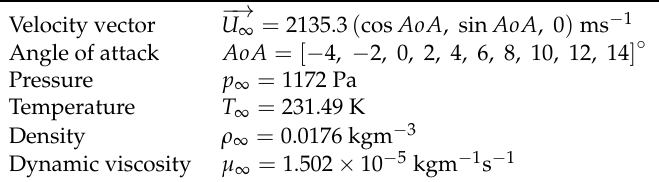
Table 2. Oncoming flow characteristics and initial